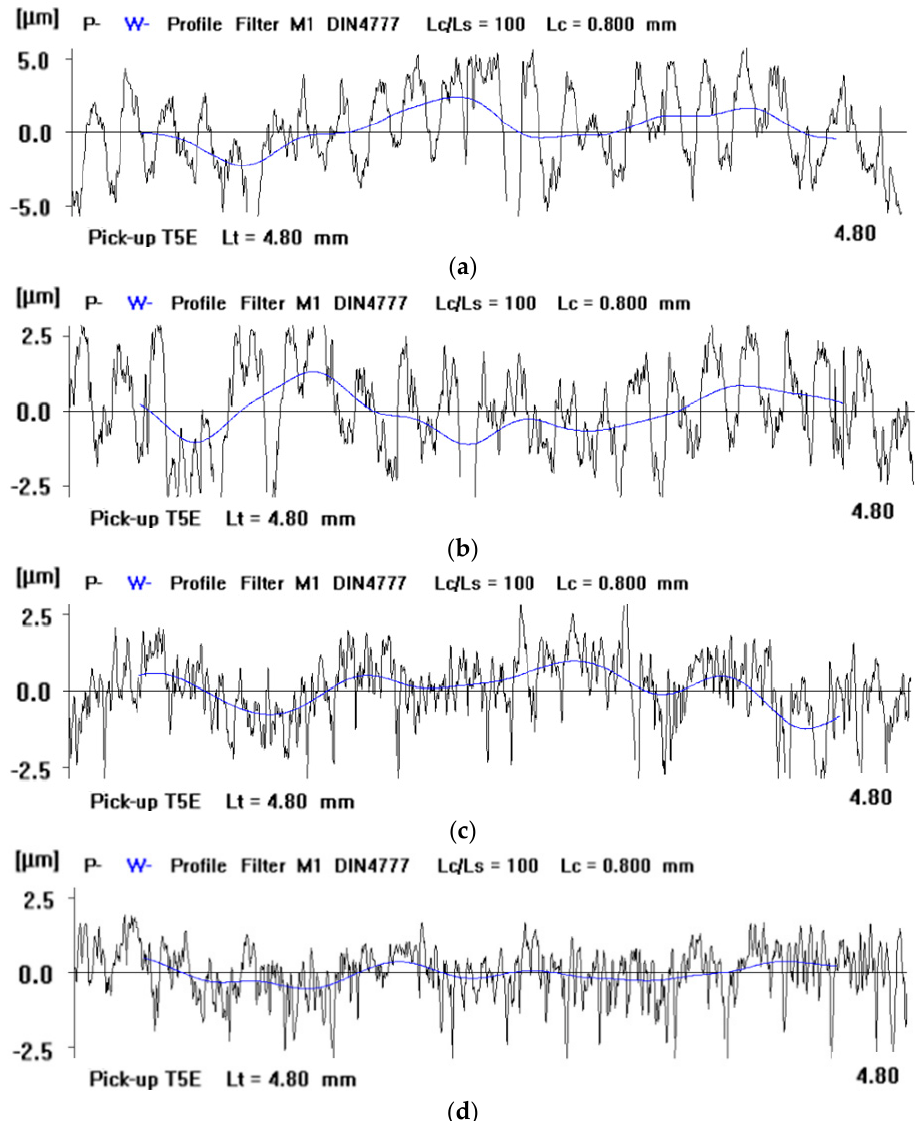
Figure 6. Comparison of the profiles measured on the surfaces of the Al 2 O 3 ceramic samples: ( a ) initial state before machining, ( b ) after test T1, ( c ) after test T2, and ( d ) after test T3.